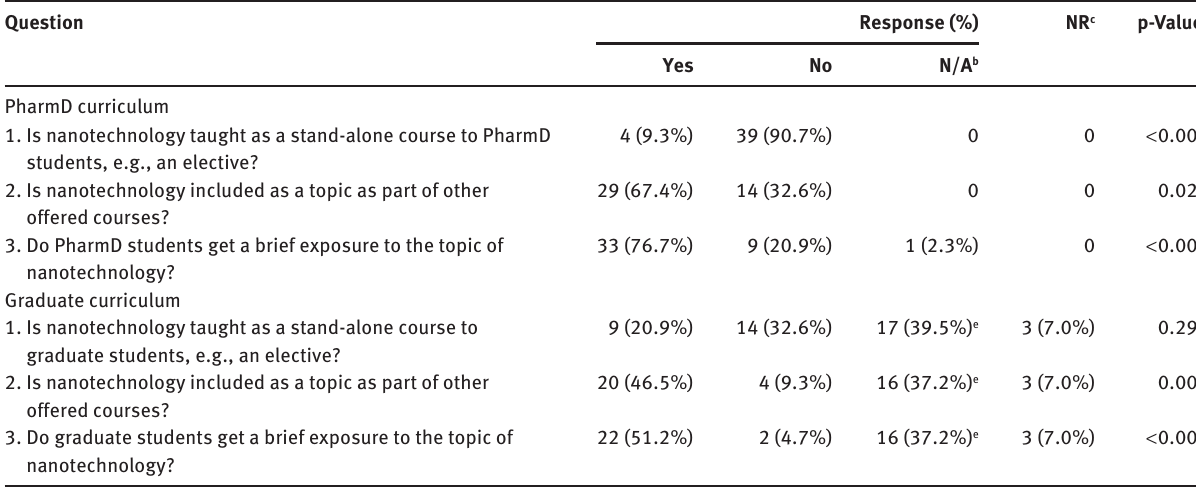
Table 1 Responses of surveyed pharmacy schools. a